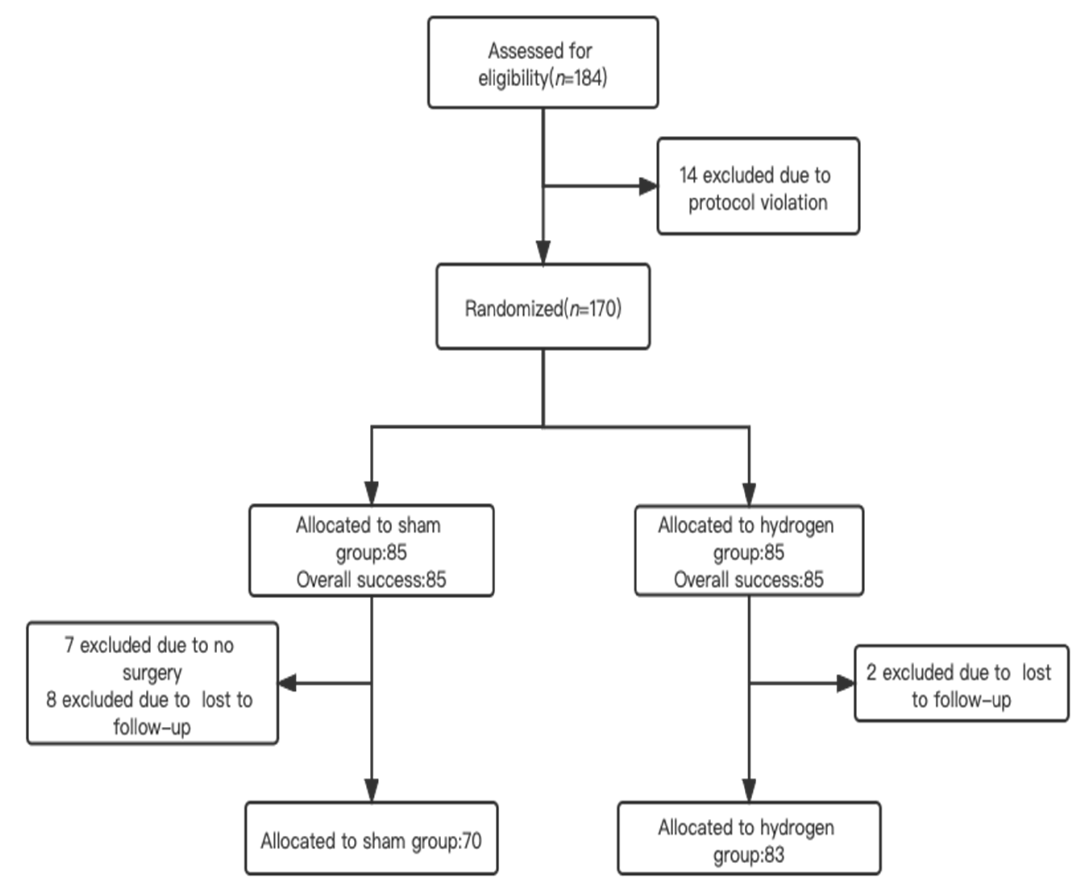
Figure 1. Patient recruitment. Table 1. Patient